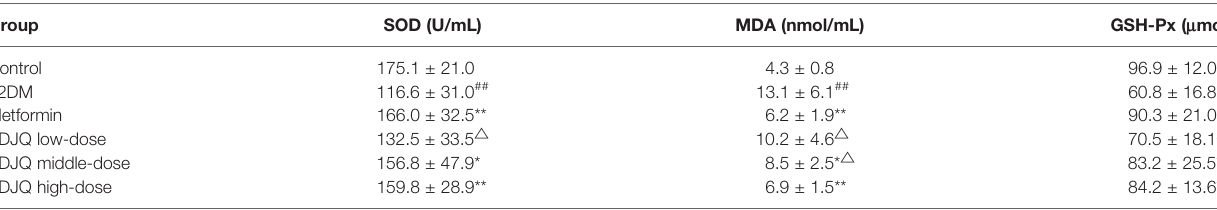
TABLE 4 | Changes in serum SOD, GSH-Px activities and serum MDA level after PDJQ treatment. Group